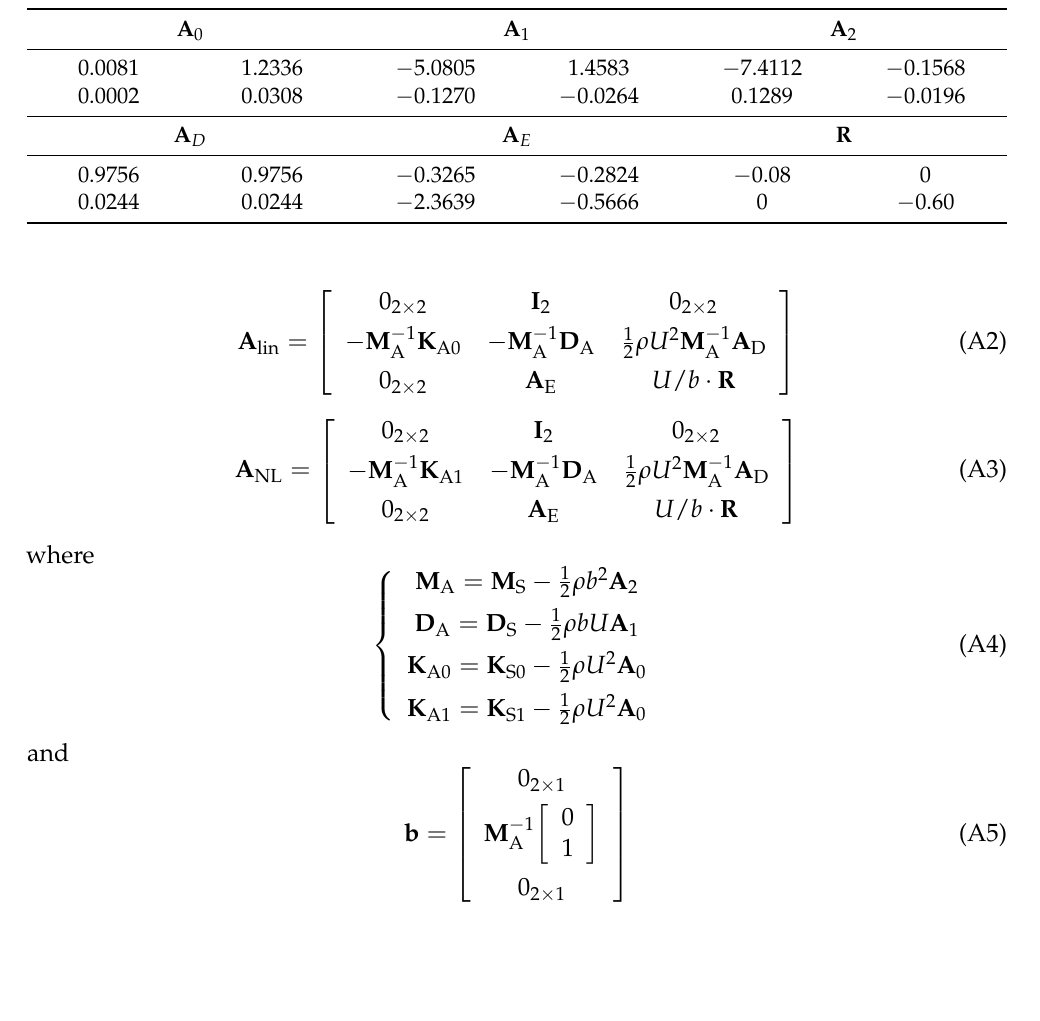
Table 2. Matrices in the equations of motion of the wing section